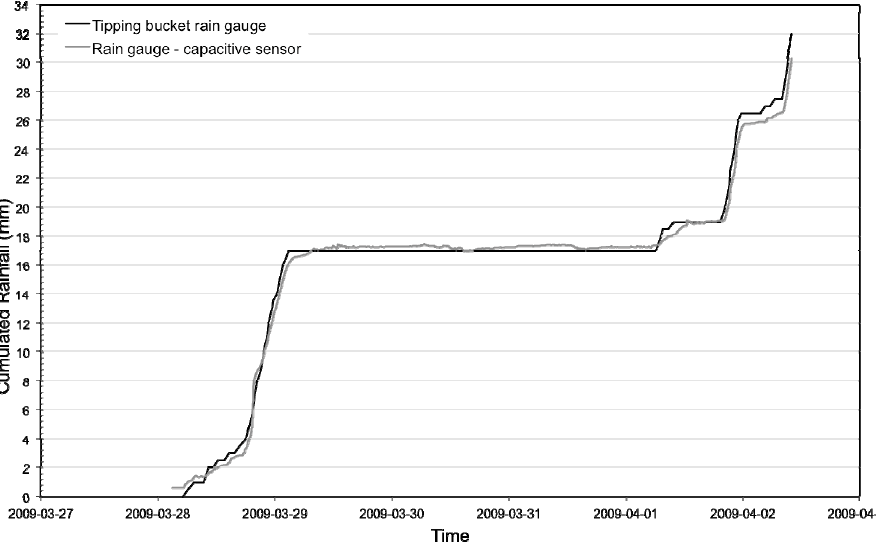
Figure 9. Rain gauge field test carried out at the Roujan catchment. Comparison between the rain gauge using the capacitive sensor and a reference tipping bucket rain gauge (INRA